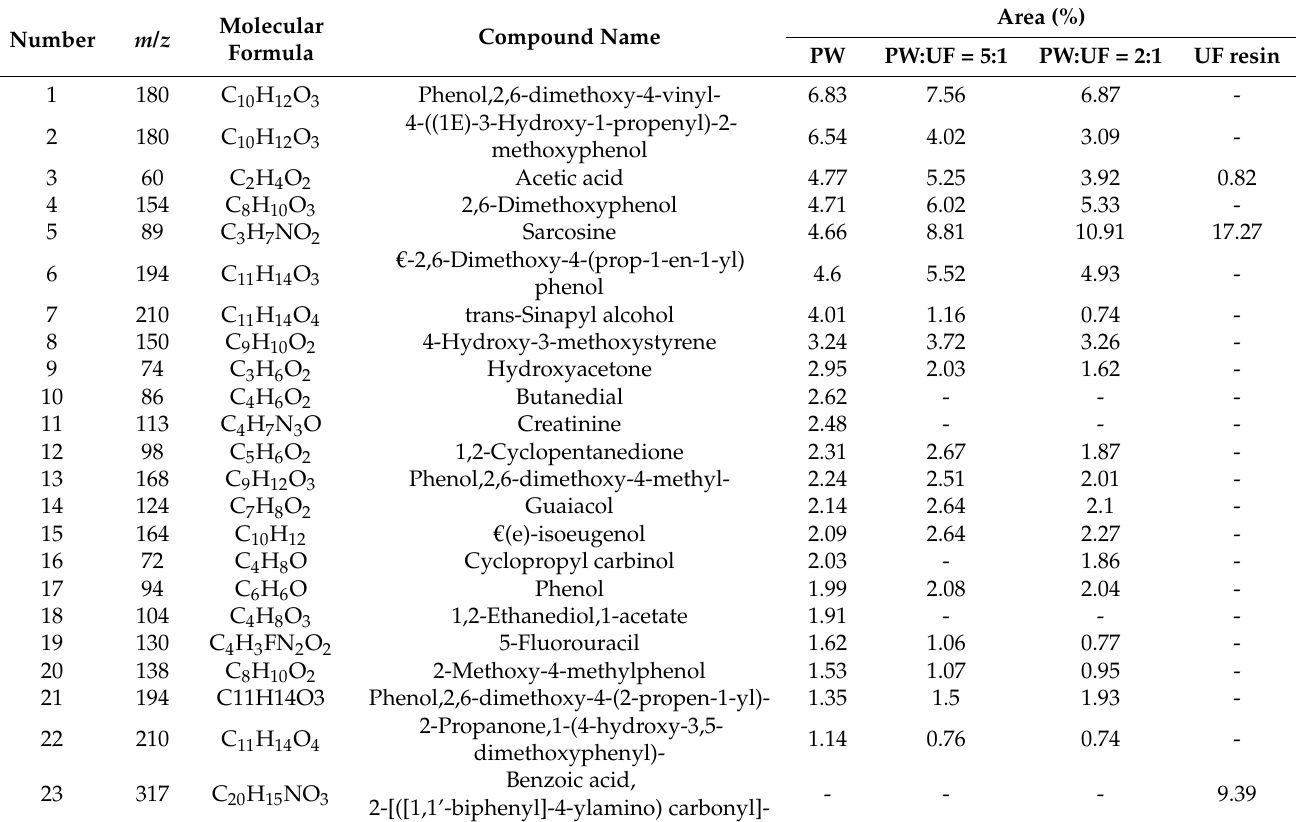
Table 2. Chemical composition analysis results of the sample pyrolysis